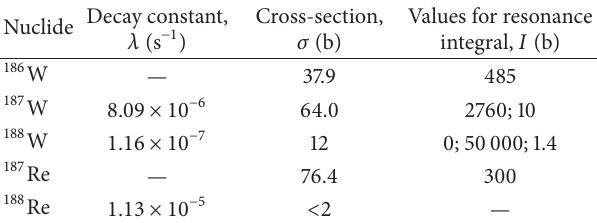
Table 1: Examples of nuclear constants for nuclides in the 188 W production